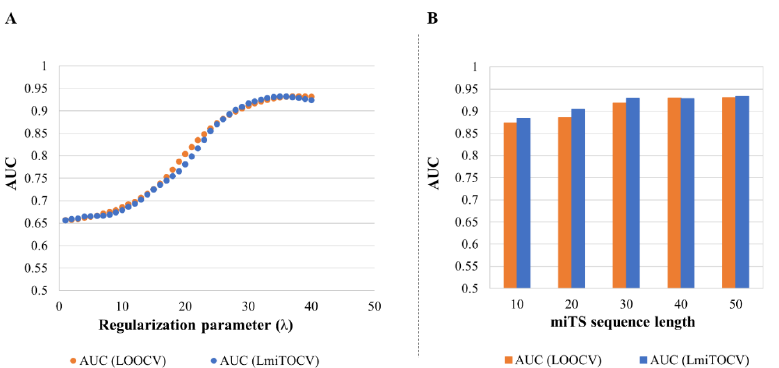
Figure 4. ( A ) Performance evaluation of regularization parameter ( λ ) in LOOCV and LmiTOCV simulation environments. The 100 times iterations of the data matrix A_(845 × 3000) (miRNA: 845 and miTS: 3000) was done with performing the model simulation. ( B ) Effect of variation on length of miTS sequences on the prediction performance of the model. As in the case of ( A ), randomized data